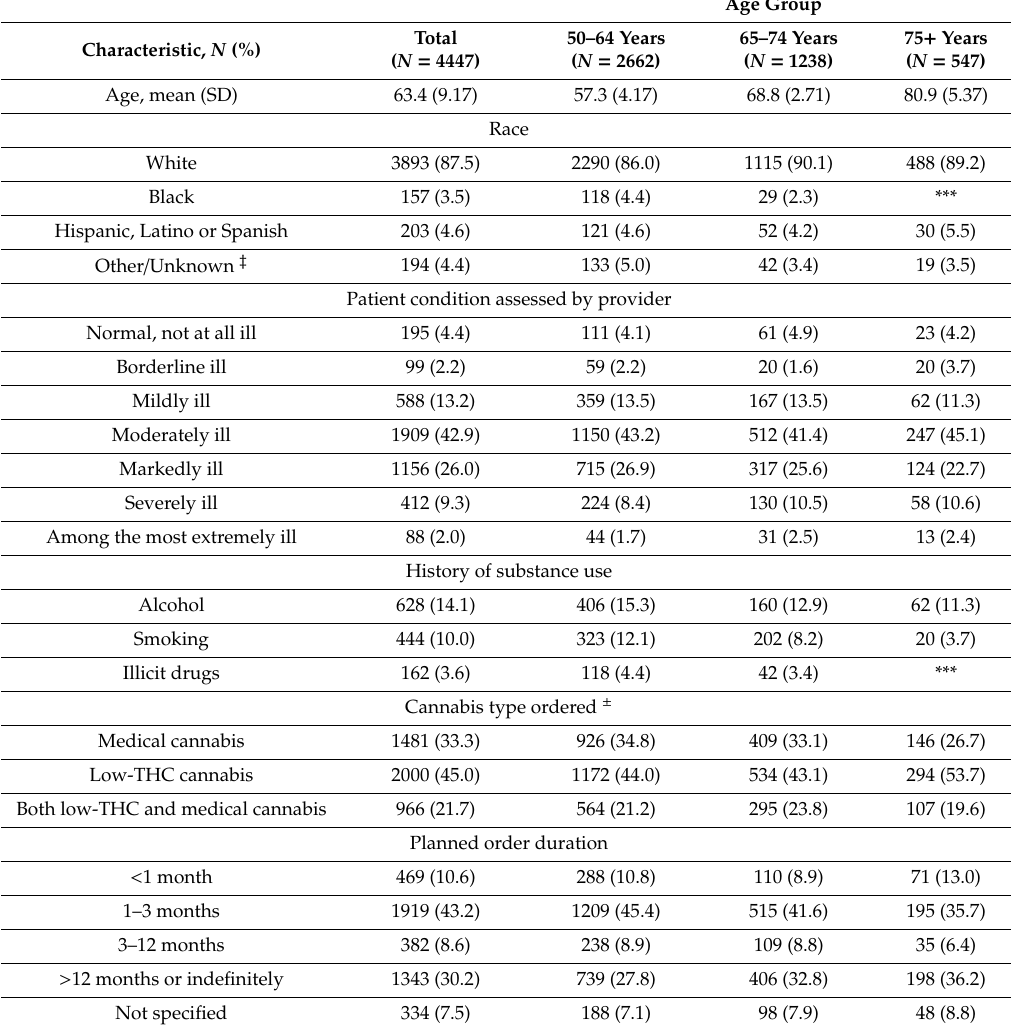
Table 1. Characteristics of Florida medical marijuana registry patients at the initial treatment visit by cannabis type